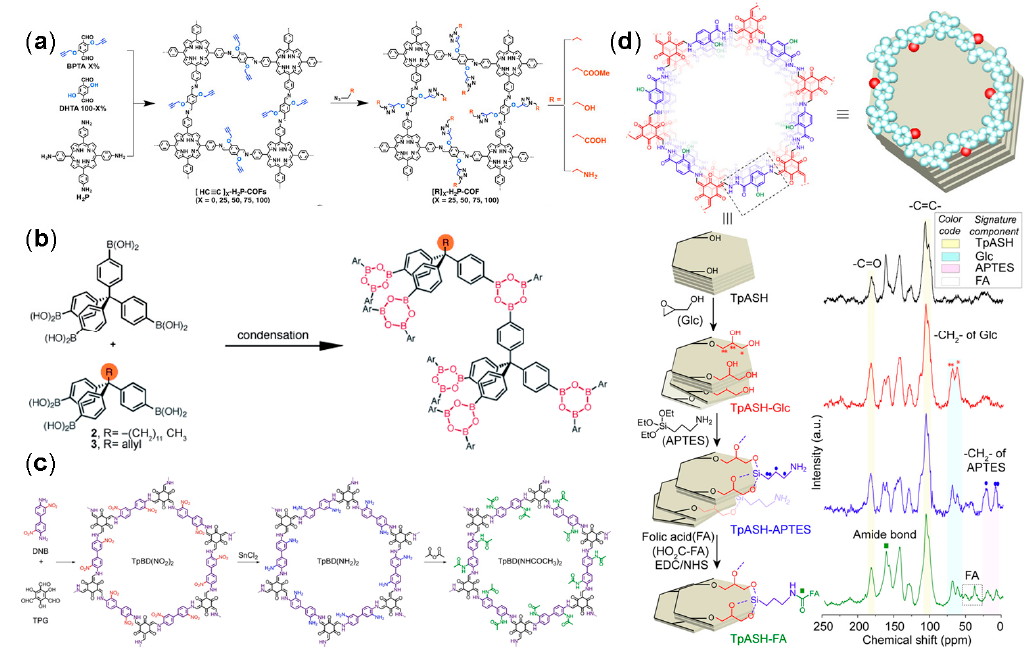
Figure 9. Schematic representations of the method to incorporate substituents: ( a ) azide-alkyne cycloaddition, reproduced with permission from [249]. Copyright American Chemical Society, 2015; ( b ) truncated mixed linker approach, reproduced with permission from [287]. Copyright John Wiley and Sons, 2012; ( c ) two-step post-synthetic method, reproduced with permission from [288]. Copyright American Chemical Society, 2016; ( d ) three-step post-synthetic method, reproduced with permission from [64]. Copyright American Chemical Society, 2017.